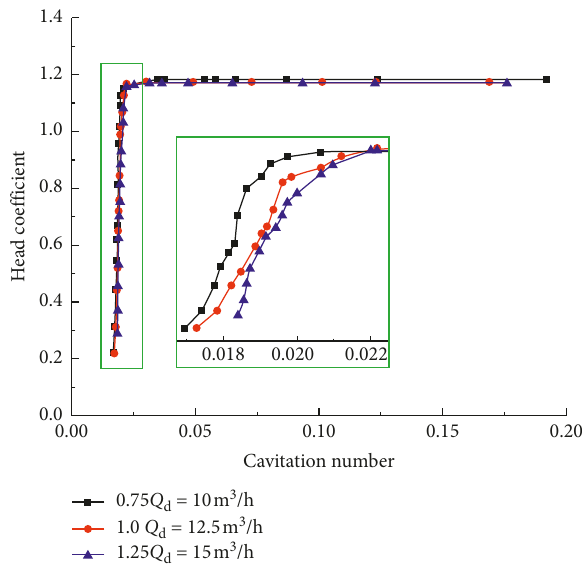
Figure 4: Cavitation performance curves under three flow